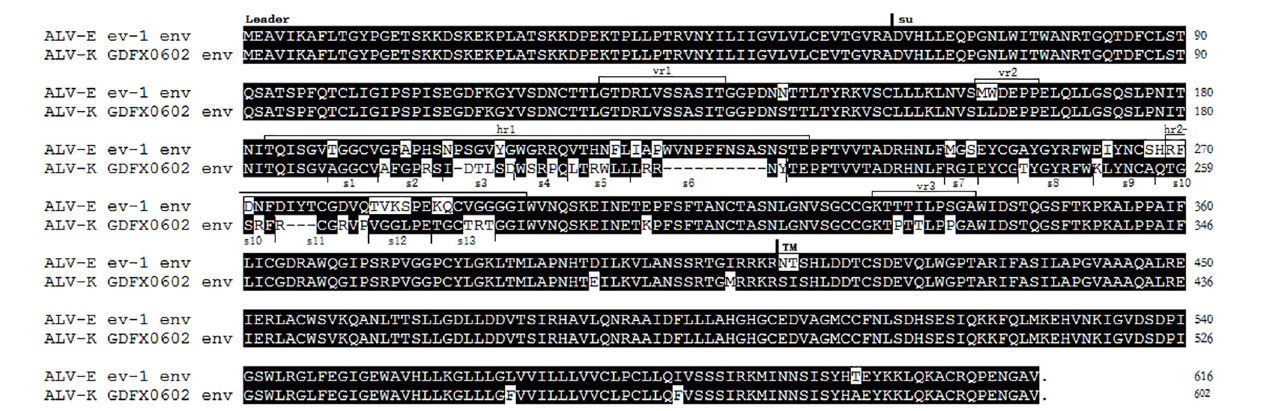
FIGURE 1 | A comparison between the amino acids of ALV-K GDFX0602 and ALV-E ev-1 Env glycoproteins, with the envelope glycoprotein leader sequence (Leader), surface glycoprotein (SU) sequence, and transmembrane glycoprotein (TM) sequence indicated, along with the sequences of the variable regions (vr1, vr2, and vr3) and host range determinant regions (hr1 and hr2) in SU and TM.